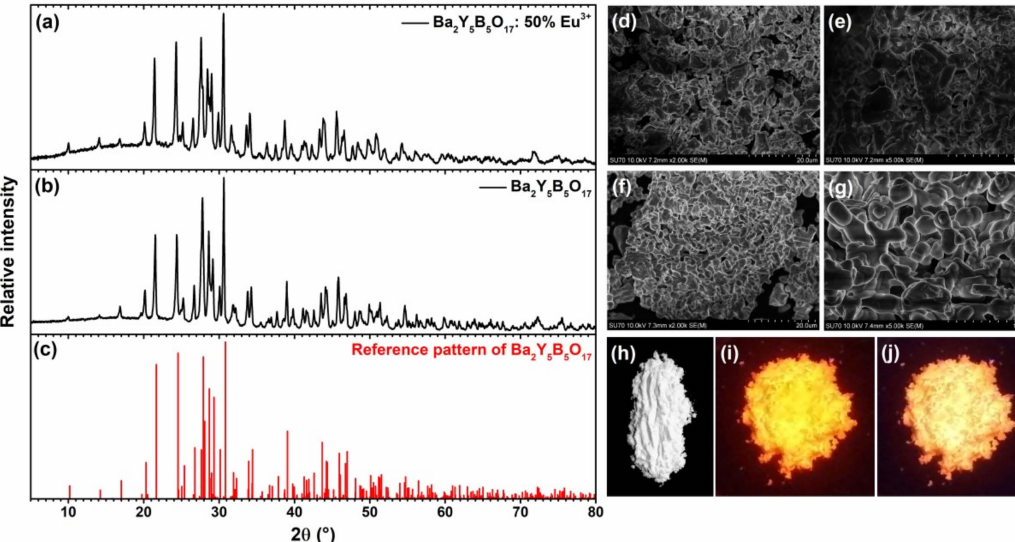
Figure 2. XRD patterns of Ba 2 Y 5 B 5 O 17 :50%Eu 3 + ( a ), Ba 2 Y 5 B 5 O 17 ( b ), and reference pattern of Ba 2 Y 5 B 5 O 17 ( c ). SEM images of Ba 2 Y 5 B 5 O 17 :50%Eu 3 + ( d , e ), and Ba 2 Y 5 B 5 O 17 ( f , g ). Digital photographs of Ba 2 Y 5 B 5 O 17 :50%Eu 3 + at daylight ( h ), and under 254 nm ( i ) and 365 nm ( j )